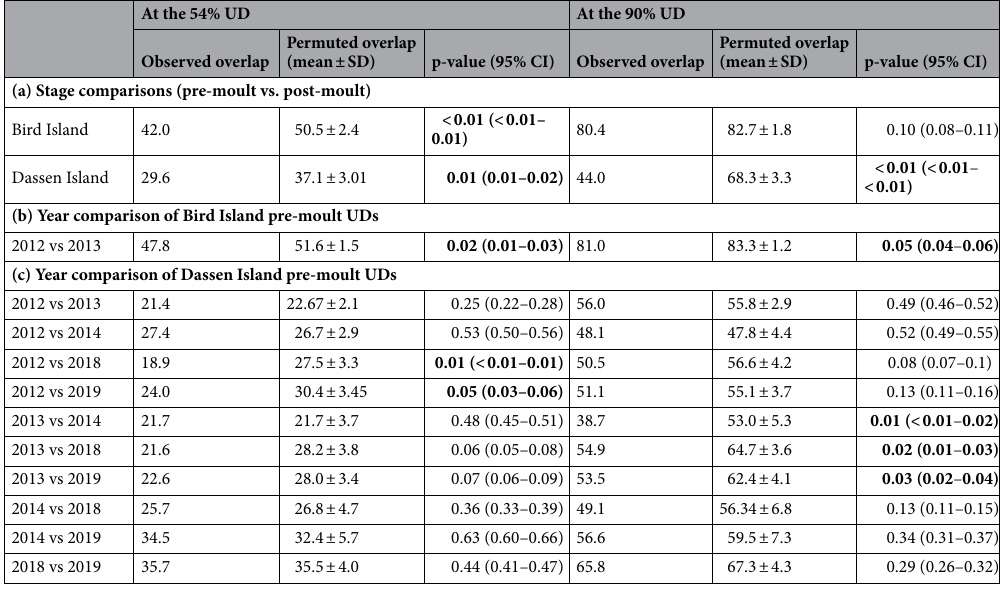
Table 2. Utilisation distribution (UD) overlap (Bhattacharyya’s Affinity 119 ) of pre- and post-moult African penguins at the core (54% UD) and distributional range (90% UD) between (a) pre- and post-moult stages, (b) year and stage at Bird Island, and (c) year and stage at Dassen Island. Significantly different UDs (bold) were identified by comparing the real (observed) overlap to the distribution of overlaps from 1000 permutations of either the stage or year labels where appropriate.